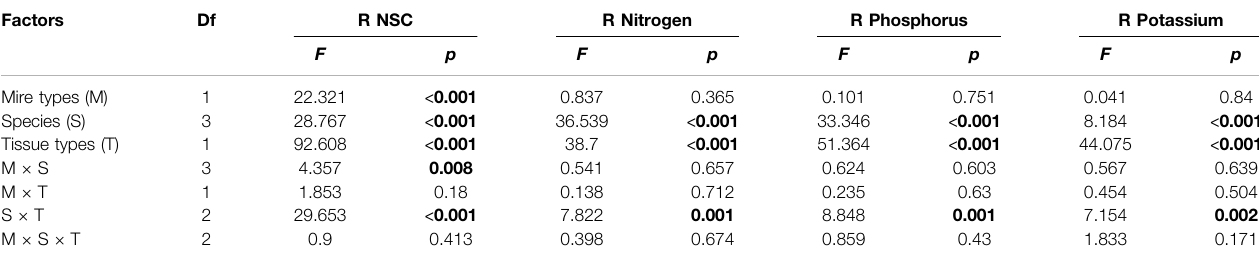
TABLE 4 | Effects of mire types, species, tissue types, and their interactions on resources remobilization between plant leaves and roots, tested with three-way nested ANOVAs. F and p values are given. R refers to remobilization ef fi ciency. Factors